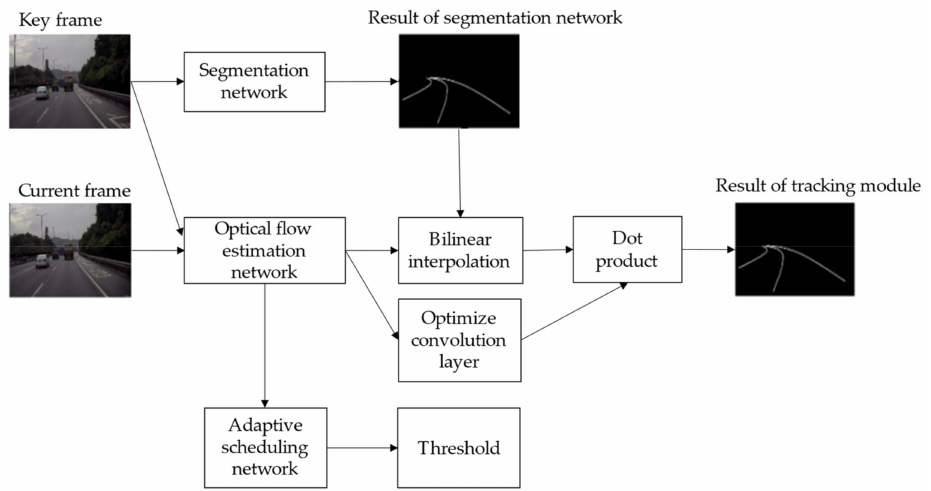
Figure 4. Pipeline of lane segmentation.